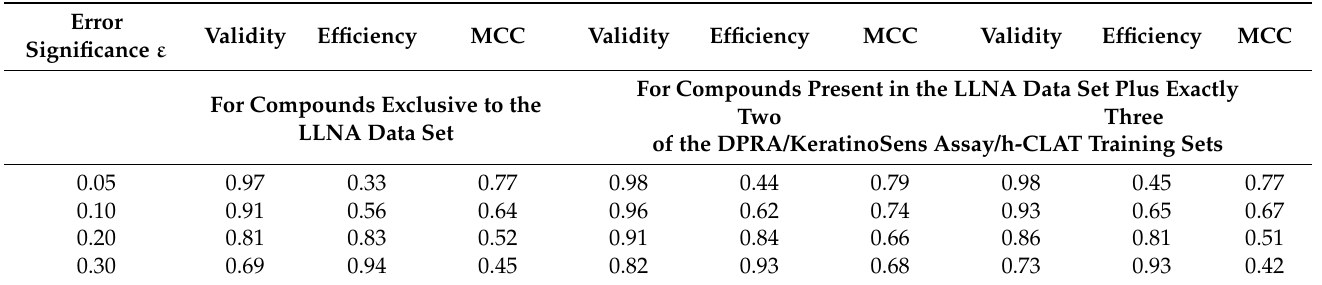
Table 7. Performance of the SkinDoctor CP:Bio model during 10-fold CV on the full LLNA data set in dependence of the number of skin sensitization assays for which experimental data are available.